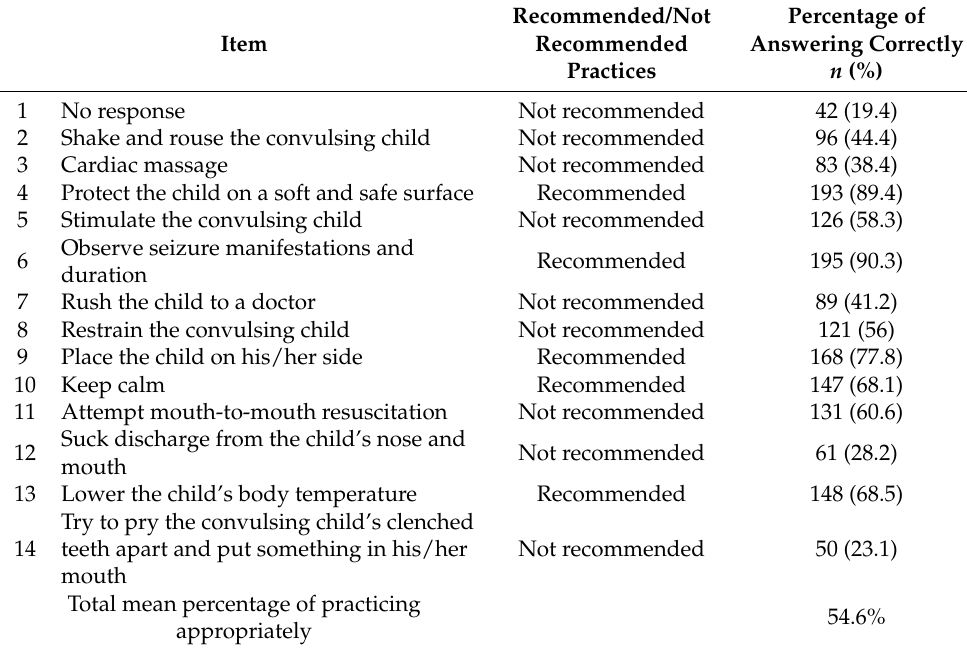
Table A4. Percentage of Childcare Providers’ Practices during FC Attacks ( n =